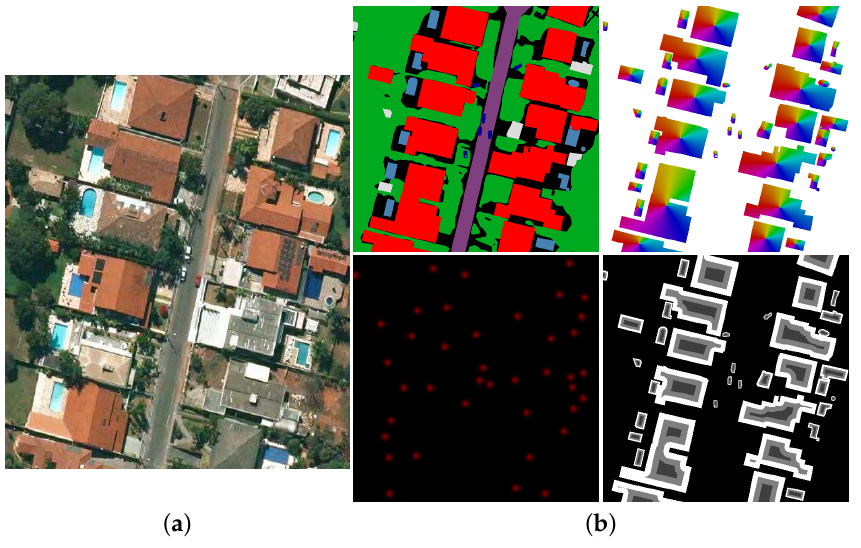
Figure 2. A Panoptic Swiftnet training example consists of an input image ( a ) and the corresponding ground-truth labels ( b) : semantic segmentation ( top left ), offset vectors ( top right) , heatmap for instance centers ( bottom left ), and weights for boundary-aware offset loss ( bottom right ). Offset directions are color coded according to the convention from the previous work in optical flow